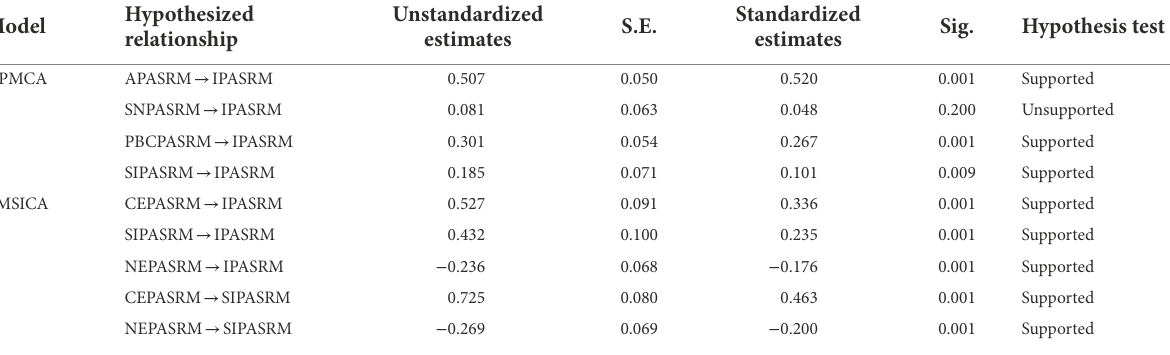
TABLE 4 The results of structural models and comparison of the results of two